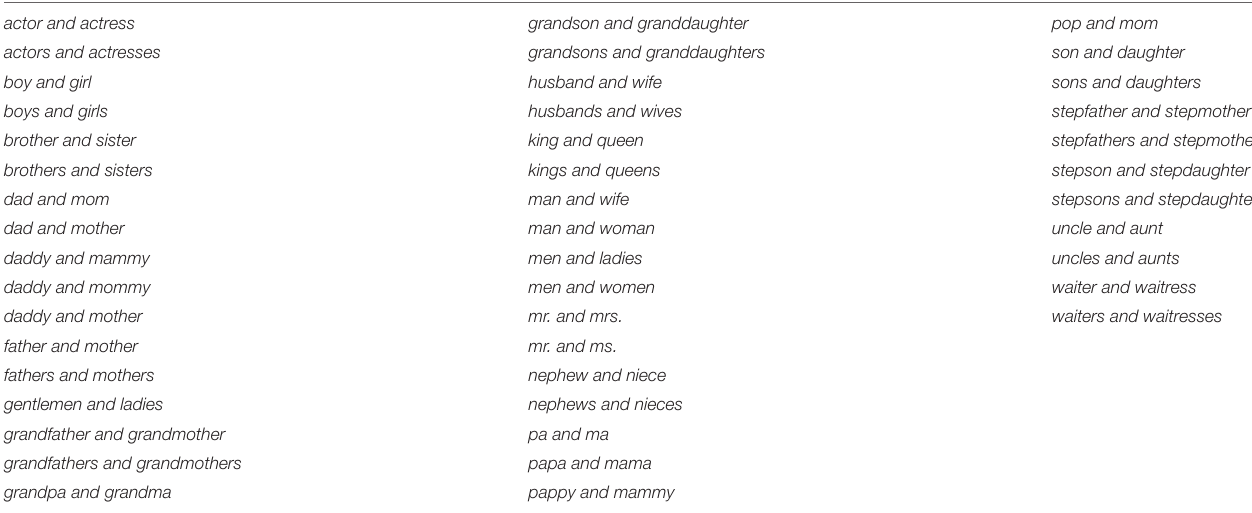
TABLE A1 | All 45 gendered binomial terms in the current dataset, listed in male-first